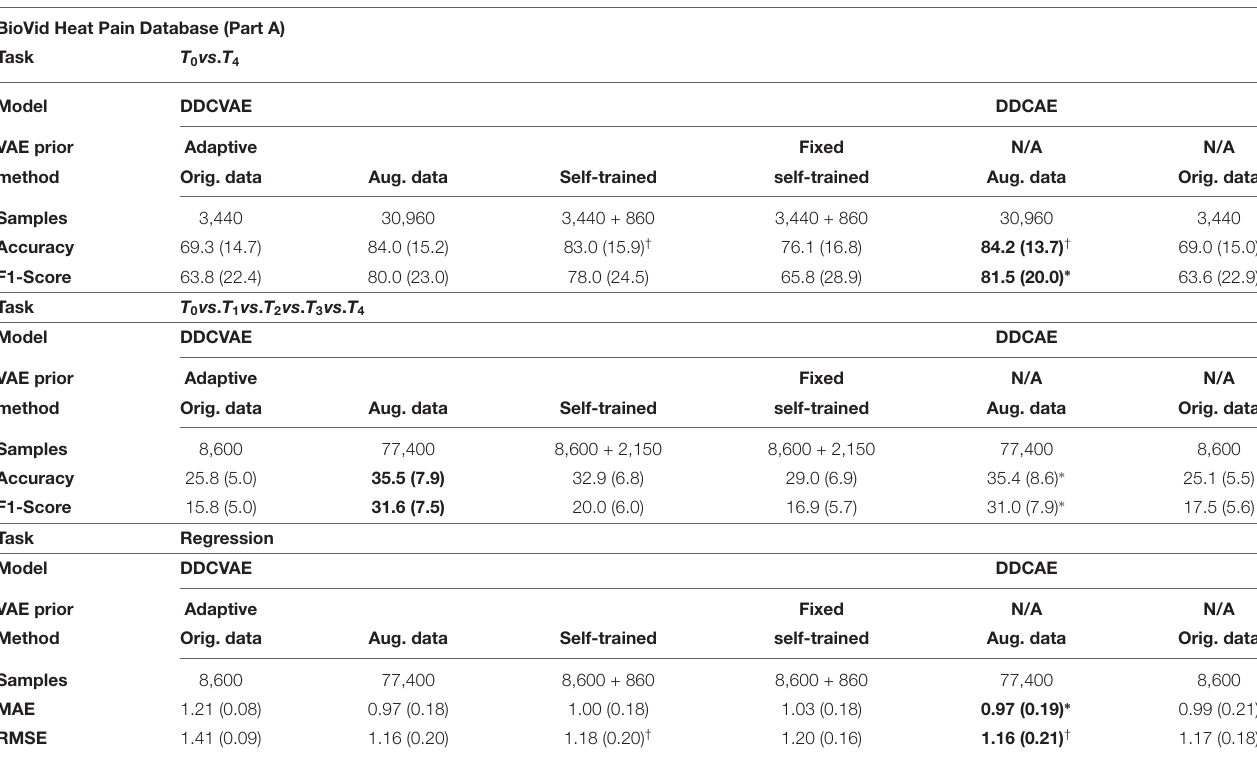
TABLE 5 | Results for the BioVid dataset in the binary, five classes, and regression setting in a Leave One Subject Out (LOSO) cross-validation evaluation setting: average performance in % (standard deviation in % ). BioVid Heat Pain Database (Part A)